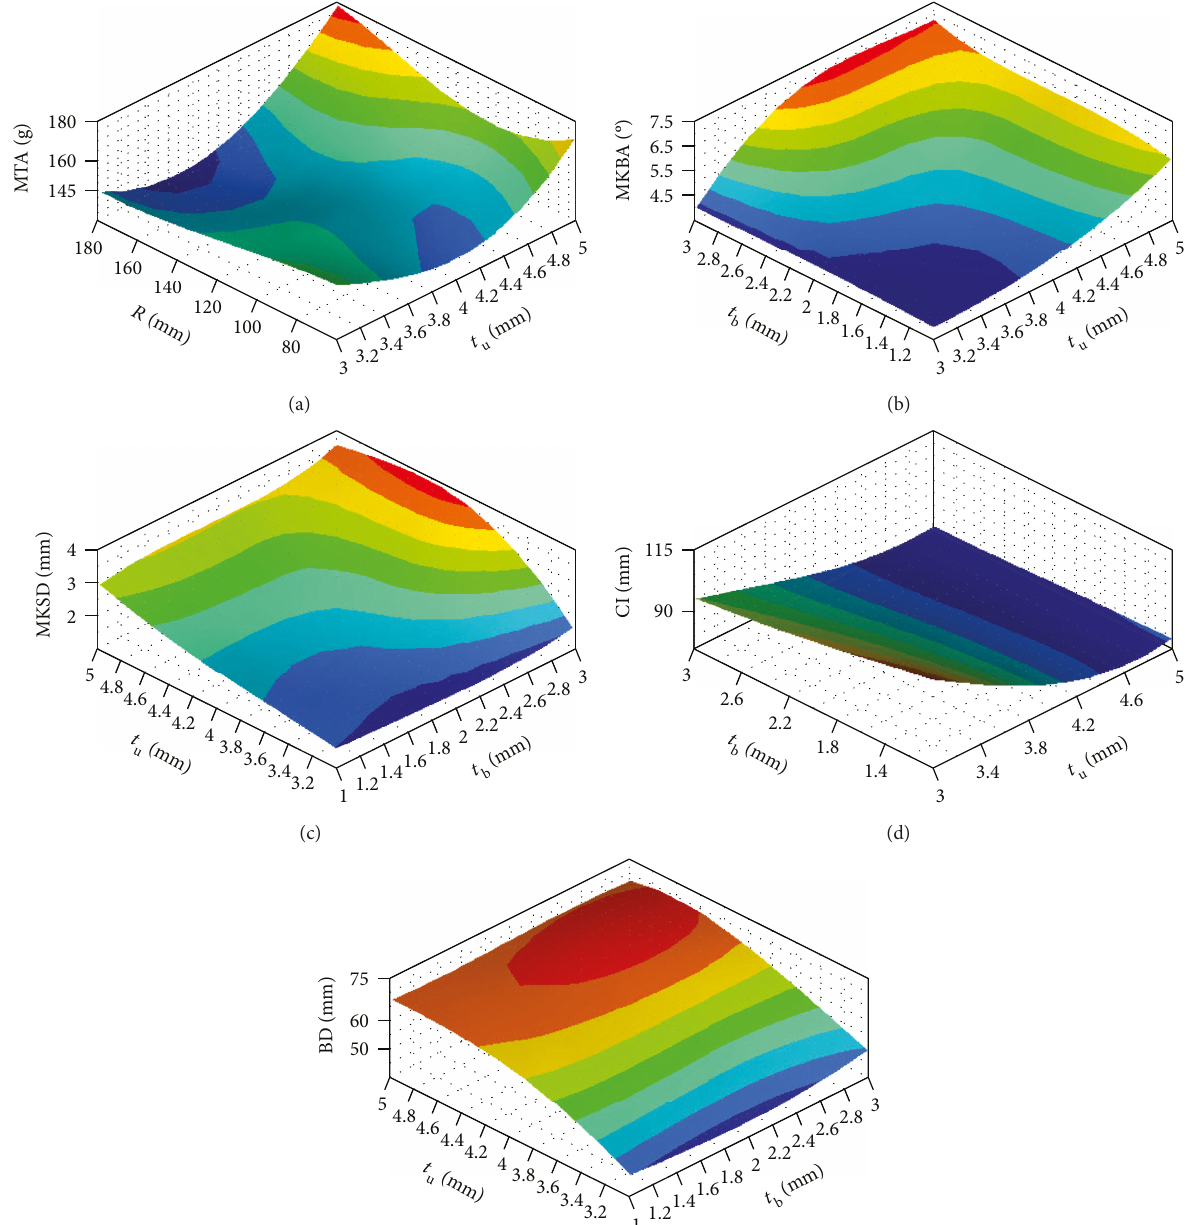
Figure 5: Response surfaces showing simultaneous e ff ects of (a) t on CI, and (e) t